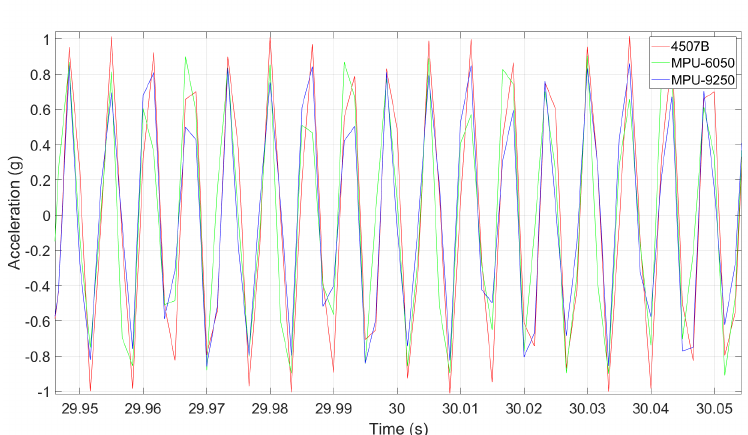
Figure 10. Responses using the universal calibrator at 159,2